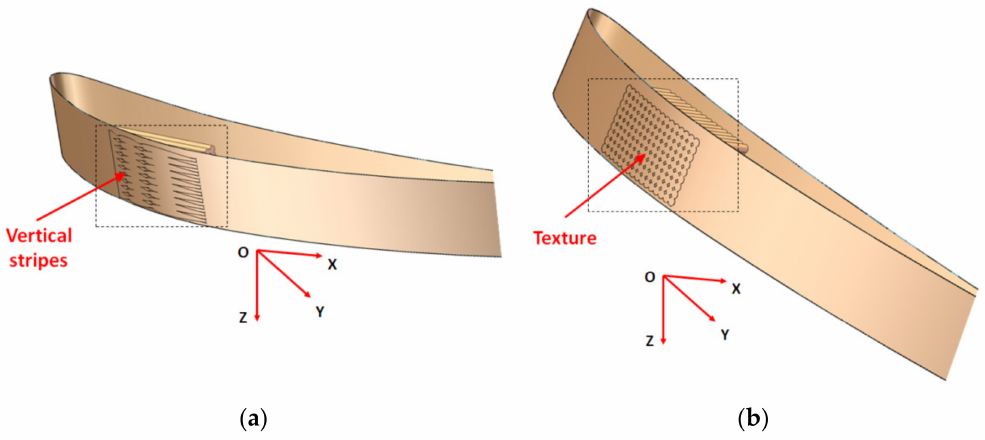
Figure 17. Theoretical texture of the airfoil surface: ( a ) glossy XY; ( b ) glossy